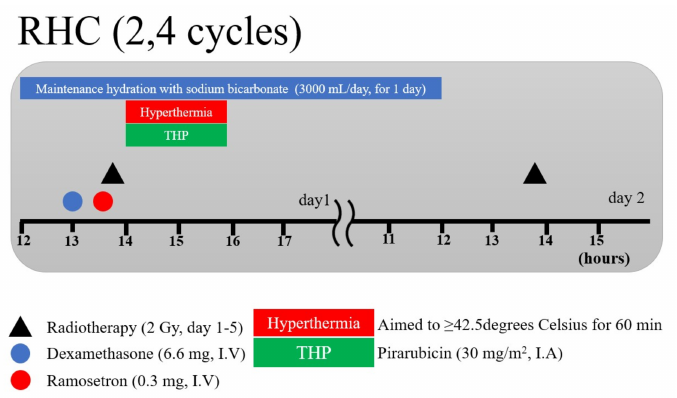
Figure A1. Radio-hyperthermo-chemotherapy protocol (1,3,5 cycles).